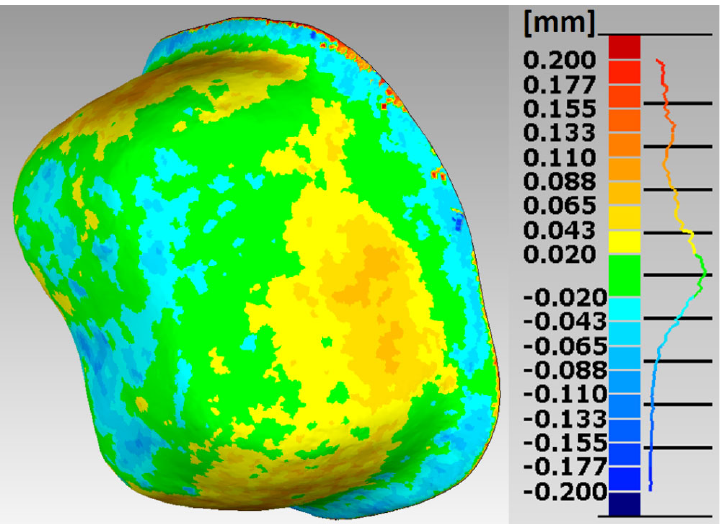
Figure 9. Map of errors in mapping the shape of a crown made of Ti6Al4V alloy in SLM for the molar tooth 36.